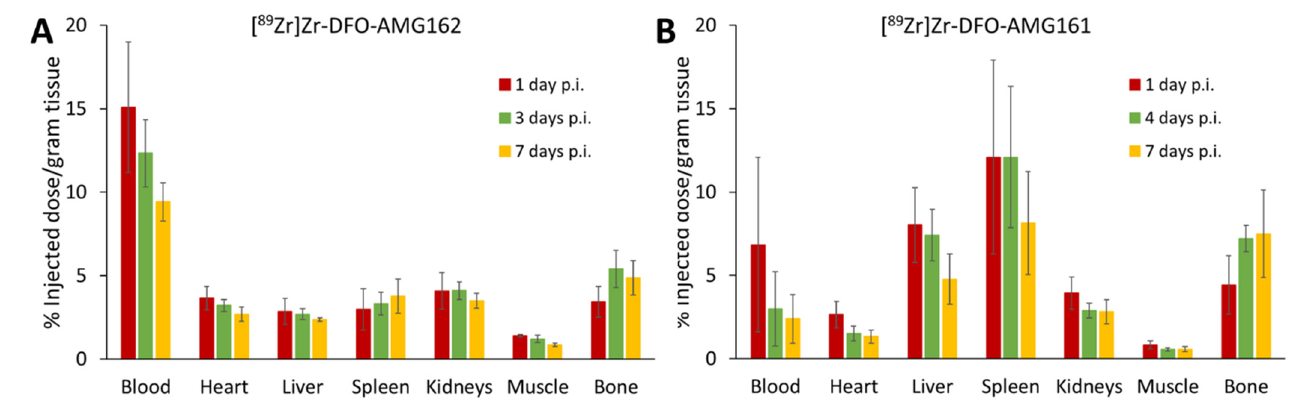
Figure 1. Ex vivo biodistribution of ( A ) [ 89 Zr]Zr-DFO-AMG162 and ( B ) [ 89 Zr]Zr-DFO-AMG161 in healthy CD-1 nude mice ( n = 4) during 7 days post injection (p.i.). (Animals per timepoint: n = 4, data graph: mean +/ − 1 standard deviation).